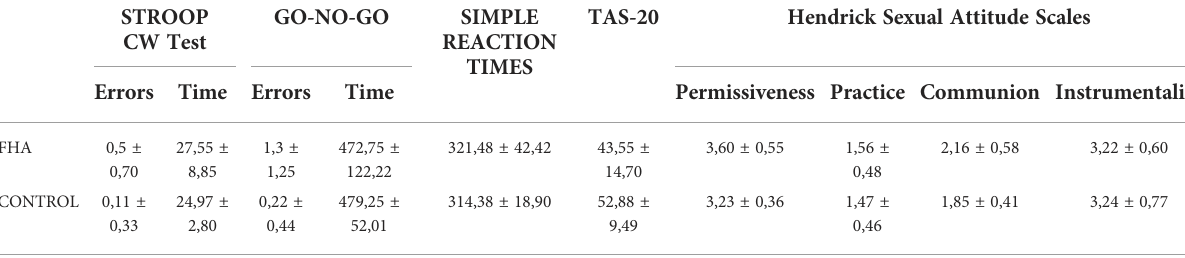
TABLE 3 Results of Stroop Color Word Test, GO-NO-GO Test, Simple Reaction Times, Toronto Alexithymia Scale (TAS-20), Hendrick Sexual Attitude Scales in FHA (Functional Hypothalamic Amenorrhea group) and in controls (control group).